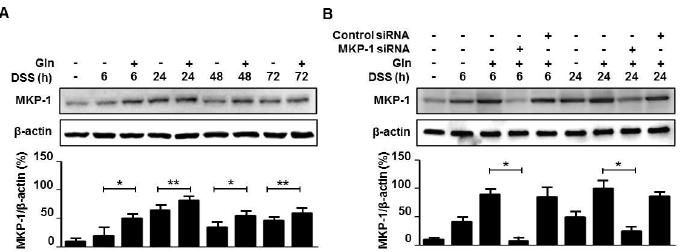
Figure 2. Gln enhances MKP-1 induction in colitis. ( A , B ) Immunoblot analysis of MKP-1. Data are representative of three independent experiments ( n = 3 mice/group/time point). * p < 0.05, ** p < 0.01 vs. DSS only group in ( A ); * p < 0.05 vs. DSS + Gln group in ( B ).